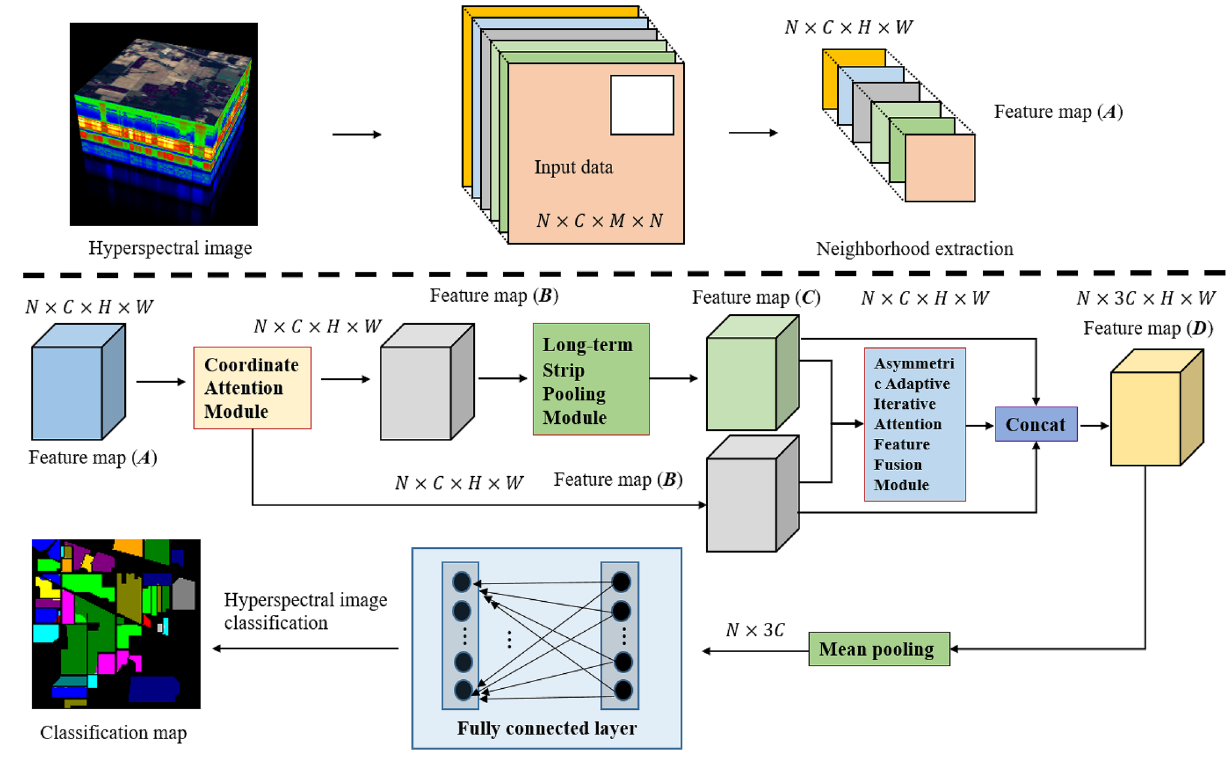
Figure 1. The overall architecture of the proposed